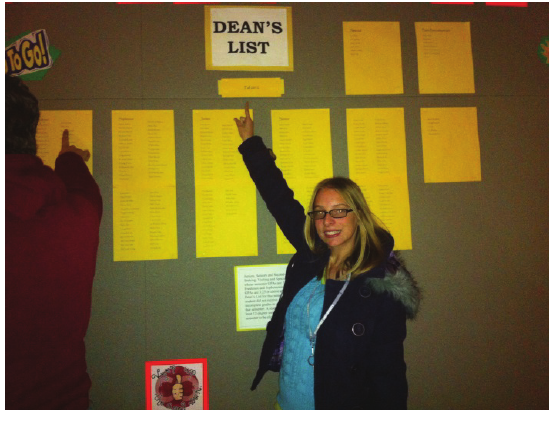
Figure 1. Kayla finding out that she made the Dean’s List at Gallaudet University.